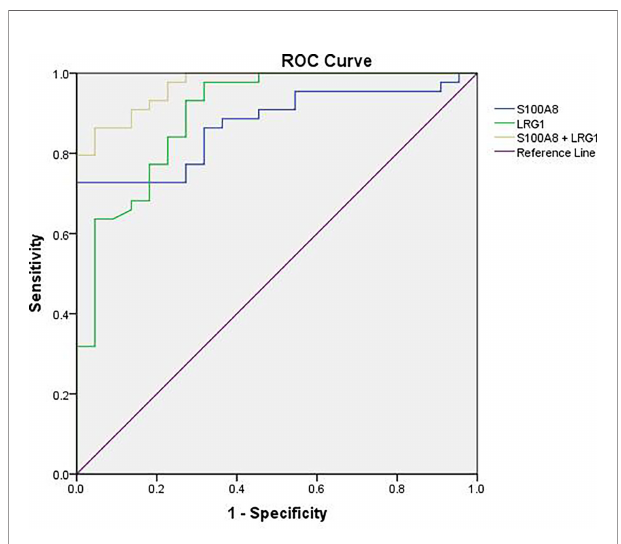
FIGURE 7 | ROC curve analysis for the sensitivity and speci fi city of S100A8 alone, LRG1 alone, and their combination in the diagnosis of